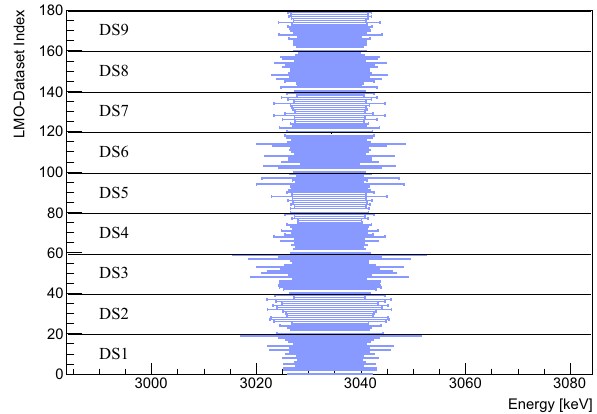
Fig. 13 Summary plot of the ROI width for every channel-dataset in this analysis. Horizontal lines demarcate each of the nine separate datasets and blue lines are a particular channel’s ROI. The x-axis range spans the entire 100 keV blinded region